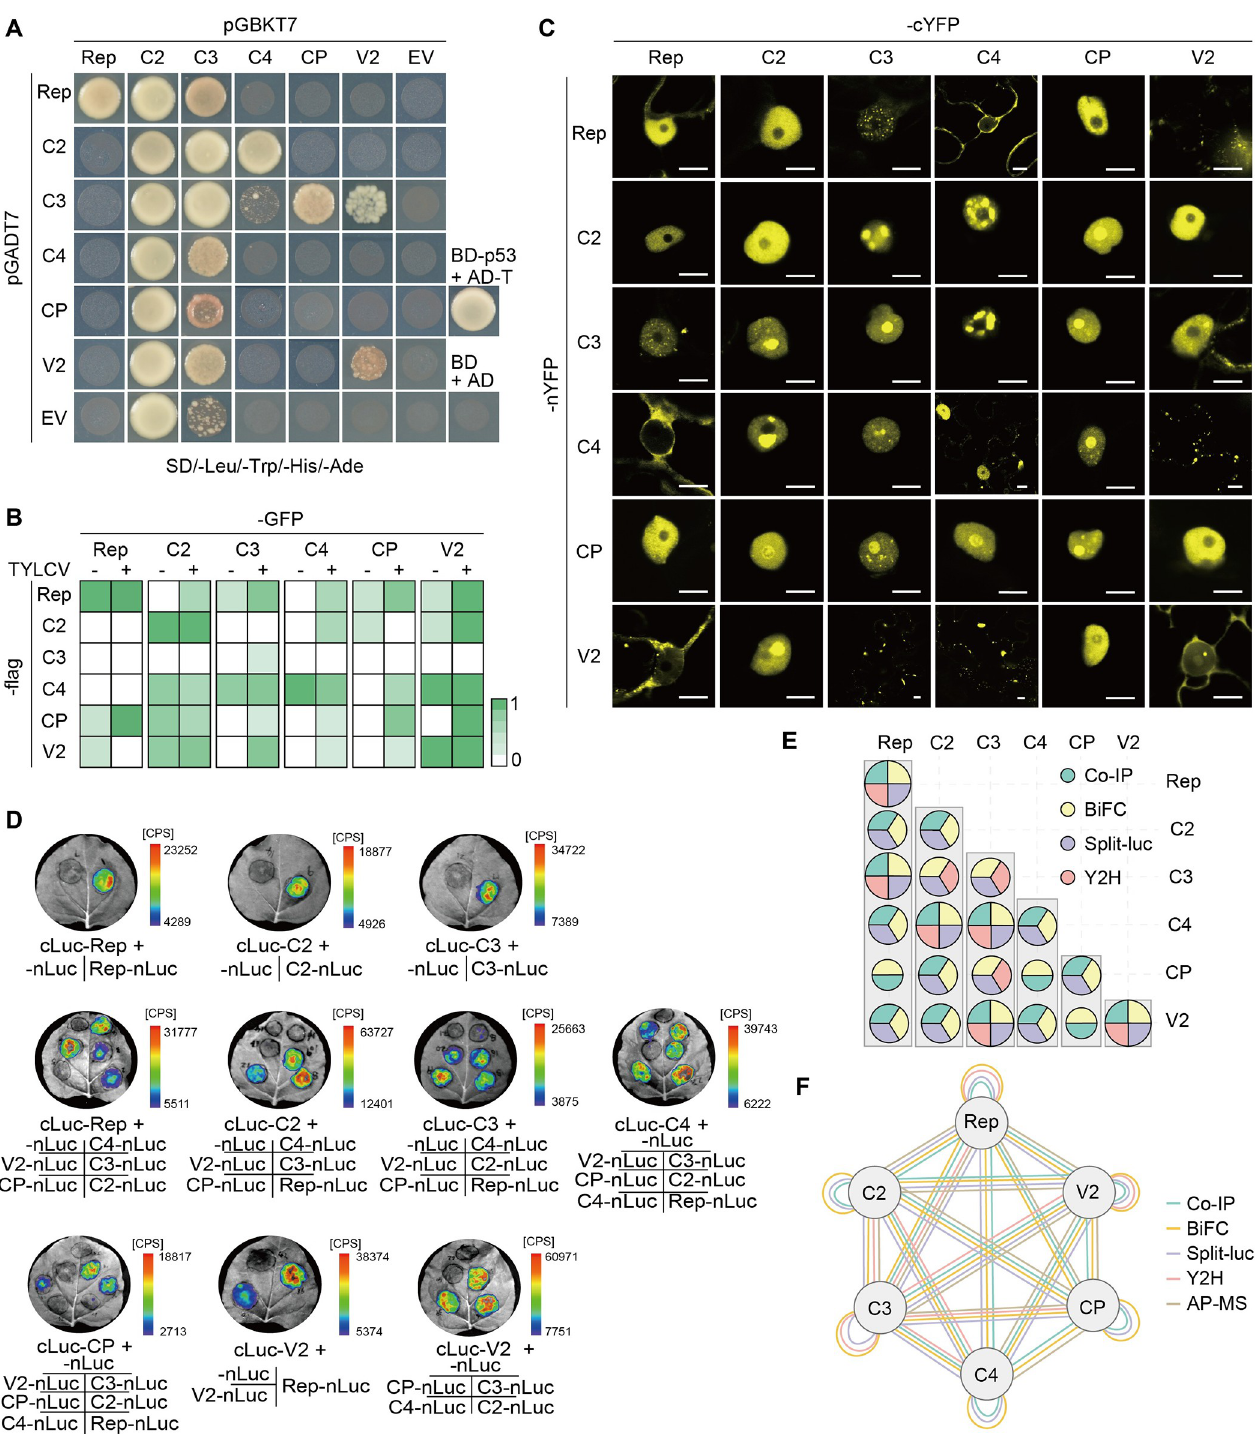
Fig 2. The proteins encoded by the plant DNA virus tomato yellow leaf curl virus (TYLCV) associate with one another in the plant cell. (A) Viral protein- protein interactions detected in yeast two-hybrid. The minimal synthetic defined (SD) medium without leucine (Leu), tryptophan (Trp), histidine (His), and adenine (Ade) was used to select positive interactions; SD without Leu and Trp was used to select co-transformants (S1 Fig). The interaction between the SV40 large T antigen (T) and the murine tumor suppressor p53 is a positive control. AD: activation domain; BD: binding domain. This experiment was repeated twice with similar results. (B) Summary of viral protein-protein interactions detected by co-immunoprecipitation (co-IP) in the absence (-) or presence (+) of TYLCV. These experiments were repeated at least three times; the colour scale represents the percentage of positive interaction results among all replicates,